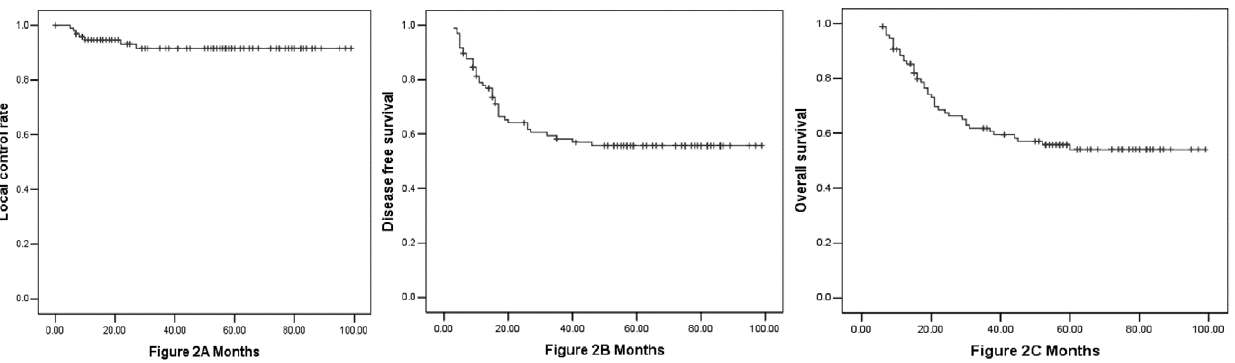
Figure 2. The local control rate, disease-free survival (DFS), and overall survival (OS) of the cohort (Fig. 2A: local control rate, Fig. 2B: DFS, Fig. 2C: OS).